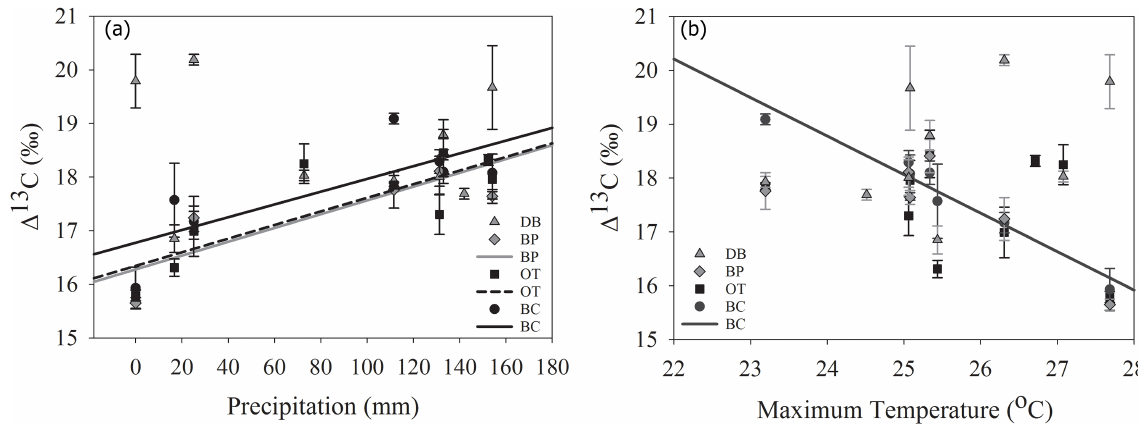
Figure 6. Relationship between tree ring (cid:49) 13 C values and early growing season (a) precipitation and (b) temperature. Site DB is represented by gray triangles, BP by gray diamonds, OT by black squares and BC by black circles. Regression lines are shown only for statistically significant relationships.